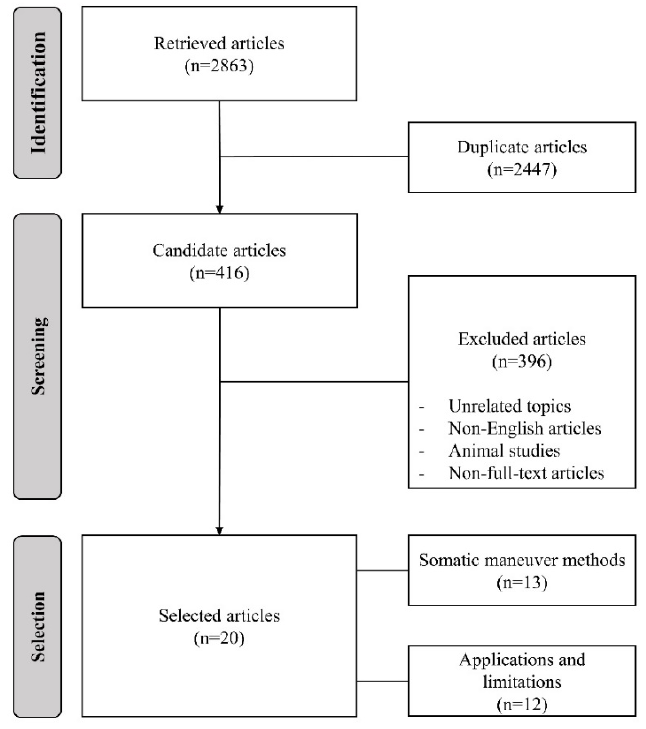
Figure 1. Flowchart of the article selection procedure.